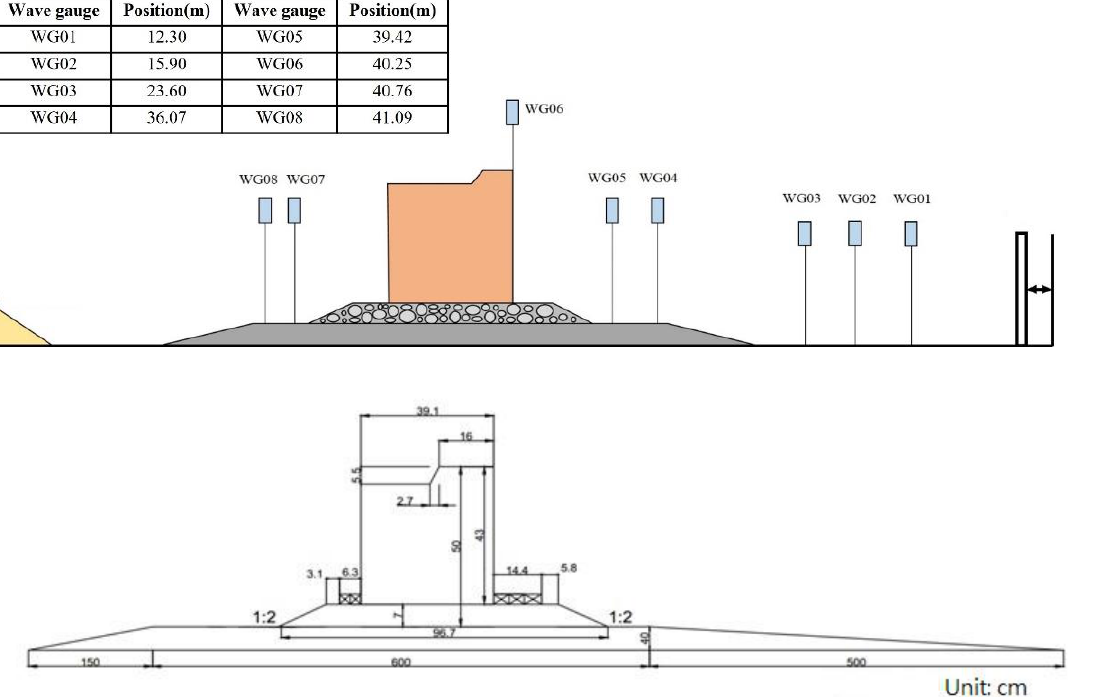
Figure 1. Schematic of experimental configuration.